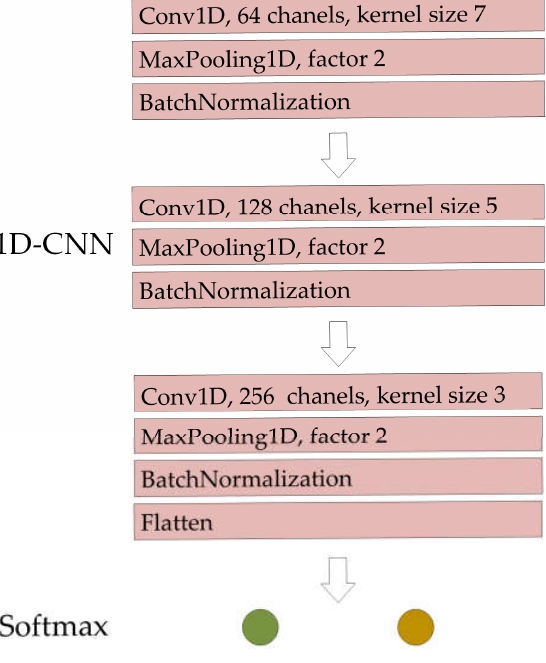
Figure 4. 1D-CNN network structure and parameters.